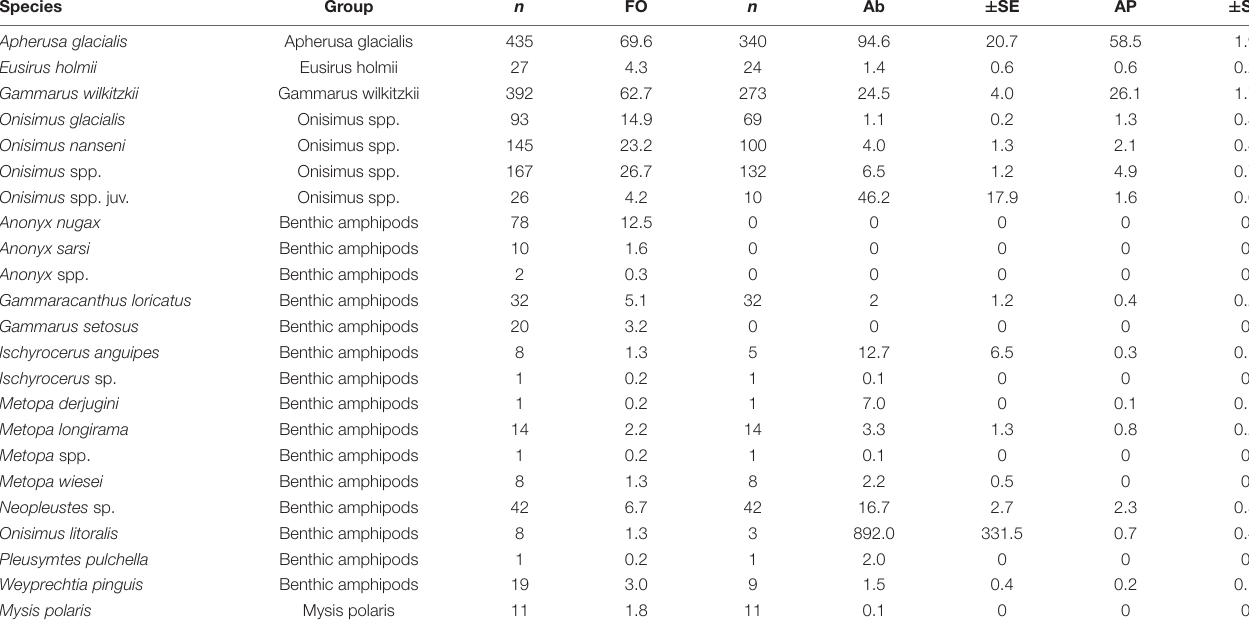
TABLE 3 | Species associated with sea ice, by their frequency of occurrence (FO, % samples), abundance (Ab, ind. m − 2 ) and aggregate percentage (AP). Species Group n FO n Ab ± SE AP ±